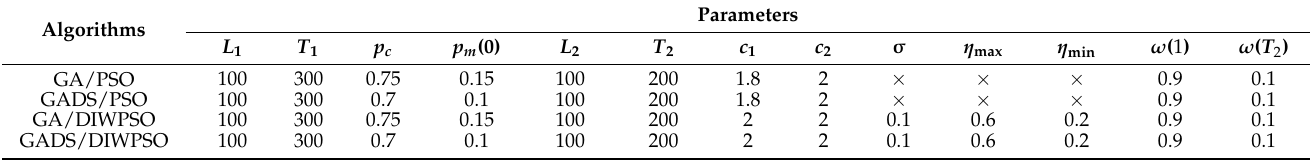
Table 10. Selection of algorithm